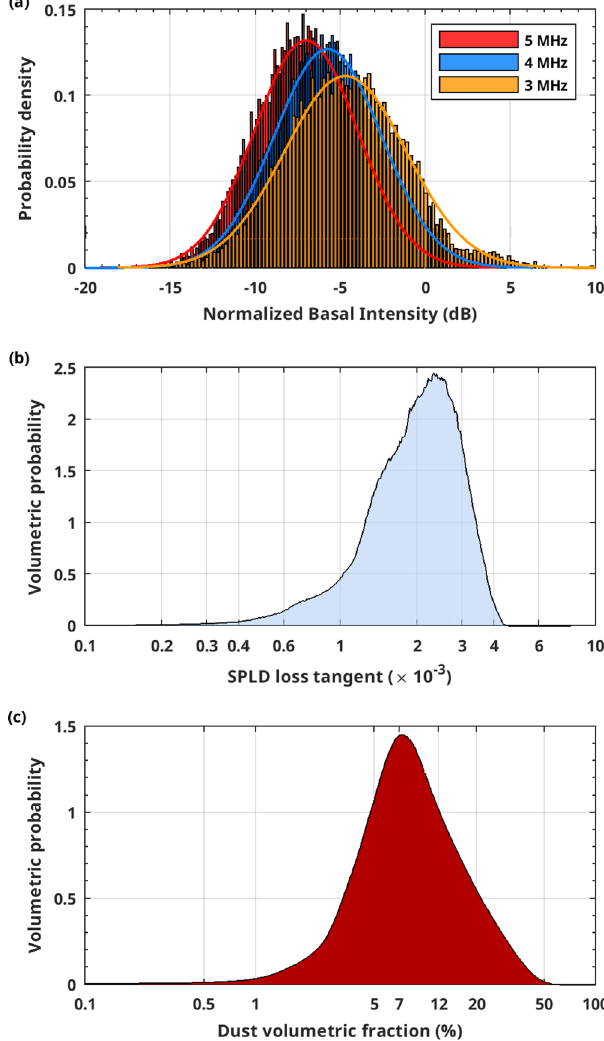
Fig.4|AnalysisofMARSISdatacollectedoutsidethebrightareas.a Normalized basal power distributions at three frequencies measured for different two-way traveltimes,intherange13 (cid:1) 25 μ s; b VolumetricprobabilityoftheestimatedSPLD loss tangent, from which the 25th percentile (tan δ SPLD =1 : 5×10 (cid:1) 3 ) and 75th per- centile (tan δ SPLD =2 : 6×10 (cid:1) 3 ) have been calculated; c dust volumetric probability from which the range 5 (cid:1) 12%, corresponding to same percentiles, has been estimated.